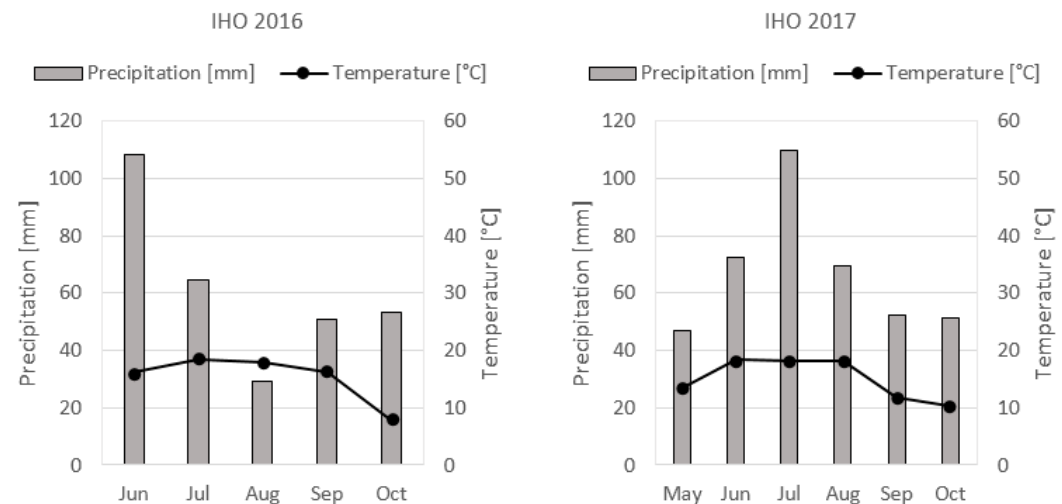
Figure 1. Precipitation [mm, bars] and mean temperature ( ◦ C; • ) during the experimental period at Ihinger Hof in 2016 and 2017 (June–October, and May–October, respectively).